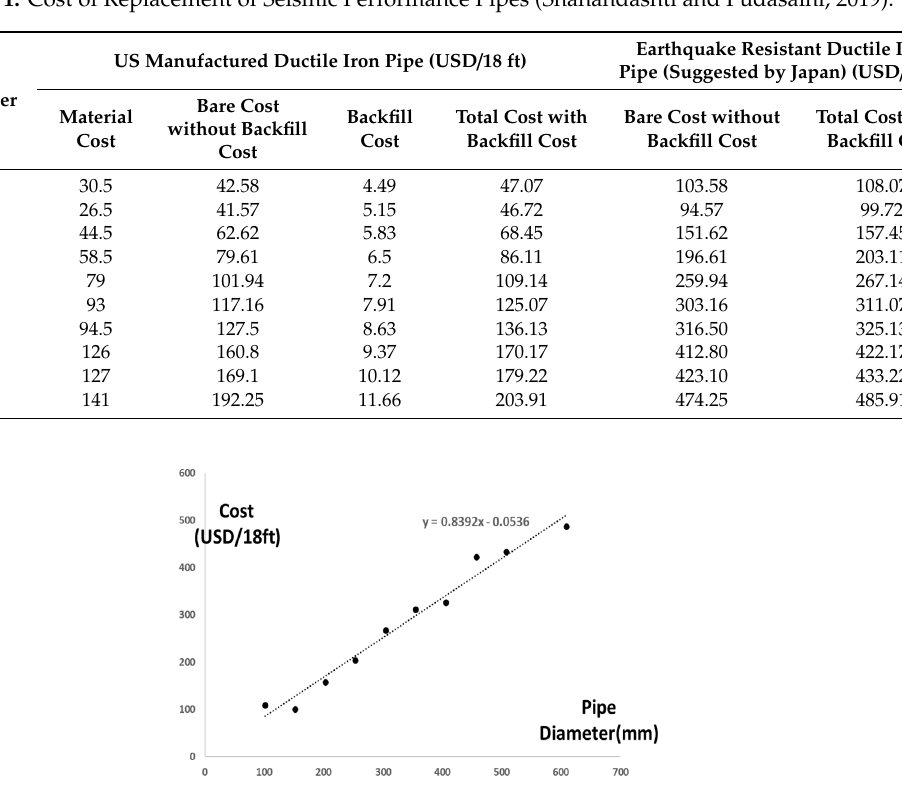
Figure 2. Cost of Seismic Performance Pipe by Diameter.